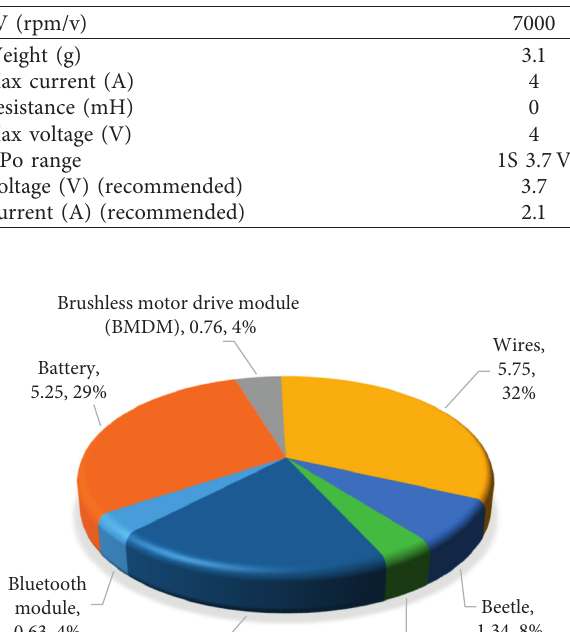
Table 1: Parameters of the 7000kV brushless micro motor.